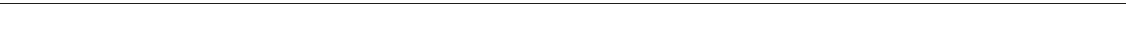
Fig. 5 Localization of IFT88 revealing a distal appendage matrix (DAM). a Three representative axial-view dSTORM images of IFT88 reveal a broad angular distribution without a clear nine-fold symmetric pattern. b Two representative sets of two-color images showing IFT88 spanning a longitudinal range relative to the location of SCLT1 (marked with a dashed line). The solid line in c depicts the distribution in the lower panel in b , whereas the dotted line illustrates normalized distributions averaged over nine data pairs. d , e 3D STORM imaging of IFT88 showing the tapered distribution of IFT88 that is wider at the distal end of the DAP region. f Three-dimensional two-color super-resolution image revealing IFT88 proteins in the gaps between neighboring SCLT1 regions, as shown in the lower image (derived from the upper-right image) in which nine SCLT1 puncta are numbered accordingly. g The region between adjacent DABs is designated as the DAM. h Model showing the localization of FBF1 and IFT88 at the DAM. i Two-color imaging of IFT88-FBF1 shows the angular coincidence between IFT88 and FBF1 at the DAM. j Histogram of angular spacing between IFT88 and FBF1. k , l The radial distribution of IFT88 was reduced in FBF1 − / − cells. m Model showing a functional role of FBF1 in maintaining the DAM spatial arrangement. Bars = 200 nm for all, except f (100 nm)